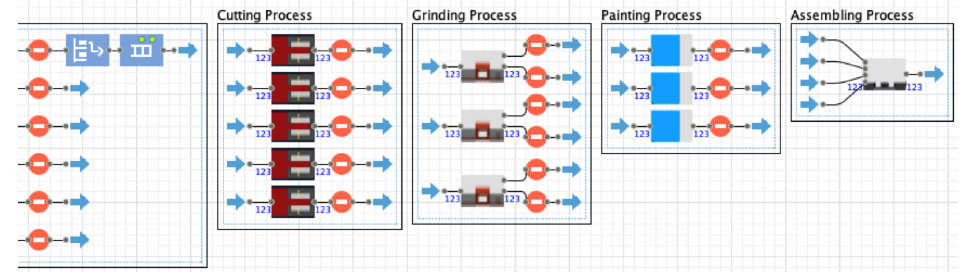
Figure 7. Logical stations of the shop floor, Software: